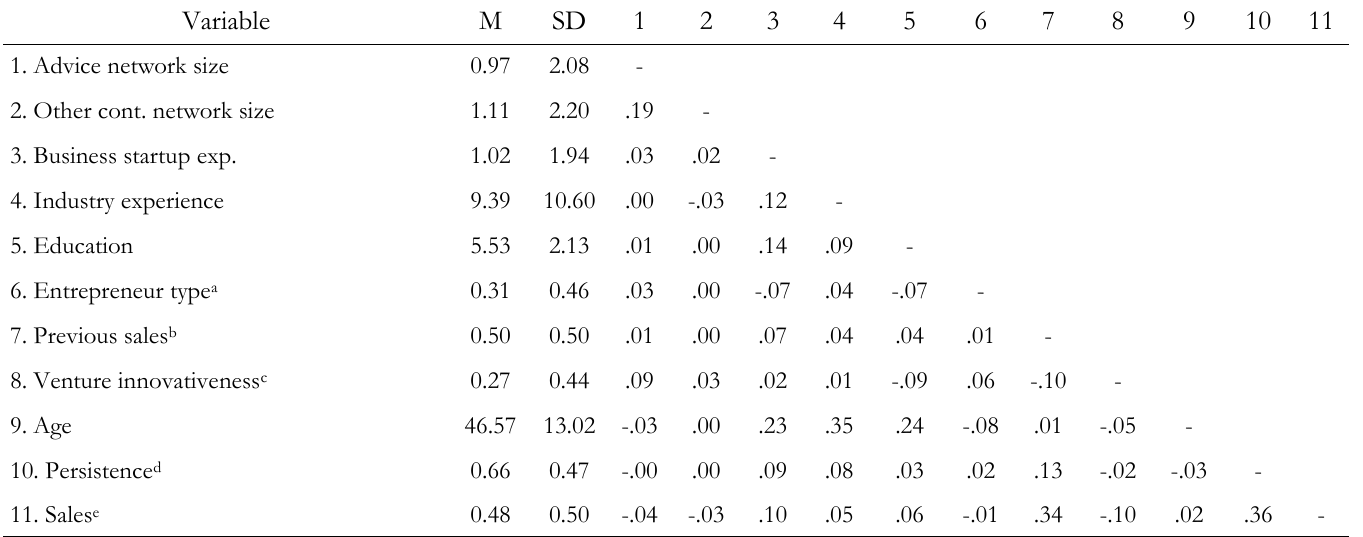
Table 1. Means, Standard Deviations, and Correlations of Study